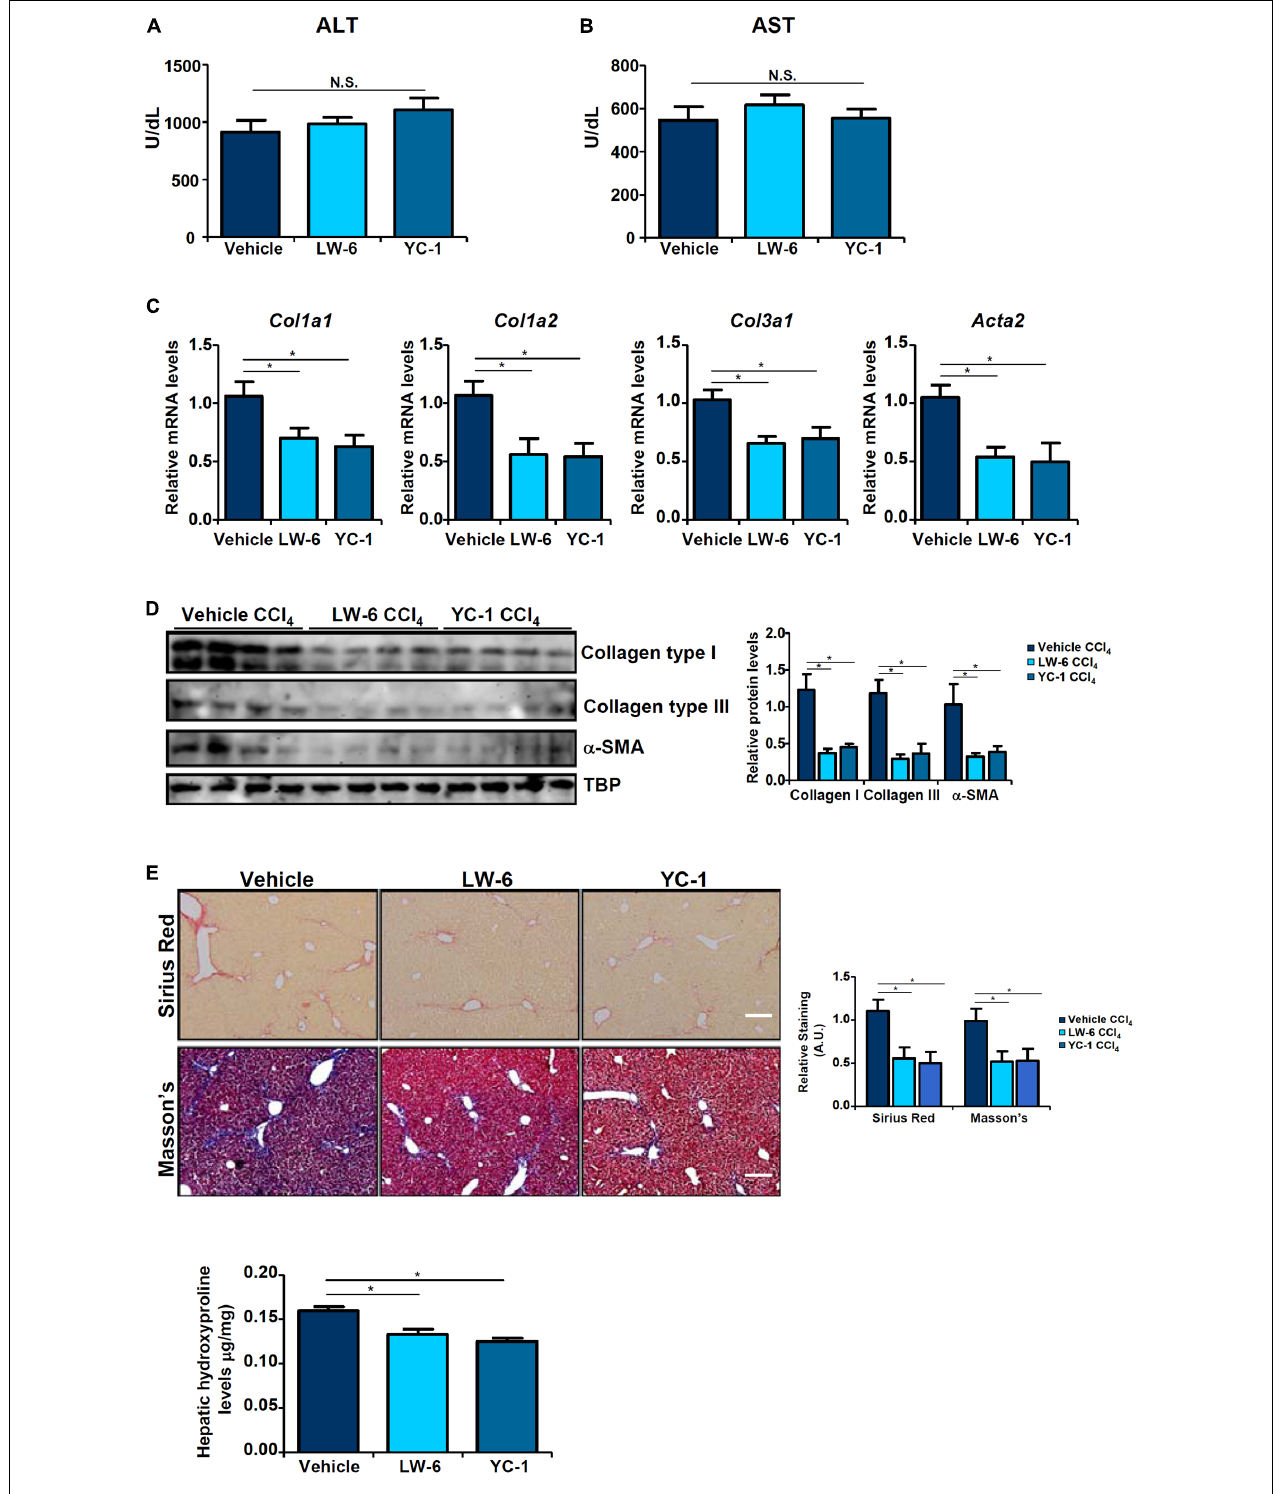
FIGURE 5 | HIF-1 α inhibition attenuates liver fibrosis in mice. Liver fibrosis was induced in by CCl 4 injection. The mice were injected with two different HIF-1 α inhibitors every other day. (A) Plasma ALT levels. (B) Plasma AST levels. (C,D) Expression levels of pro-fibrogenic genes were examined by qPCR and Western. (E) Paraffin sections were stained with picrosirius red and Masson’s trichrome. (F) Hepatic hydroxylproline levels. N = 8 mice for each group. Error bars represent SD (* p < 0.05, two-way ANOVA with post-hoc Scheffe test).